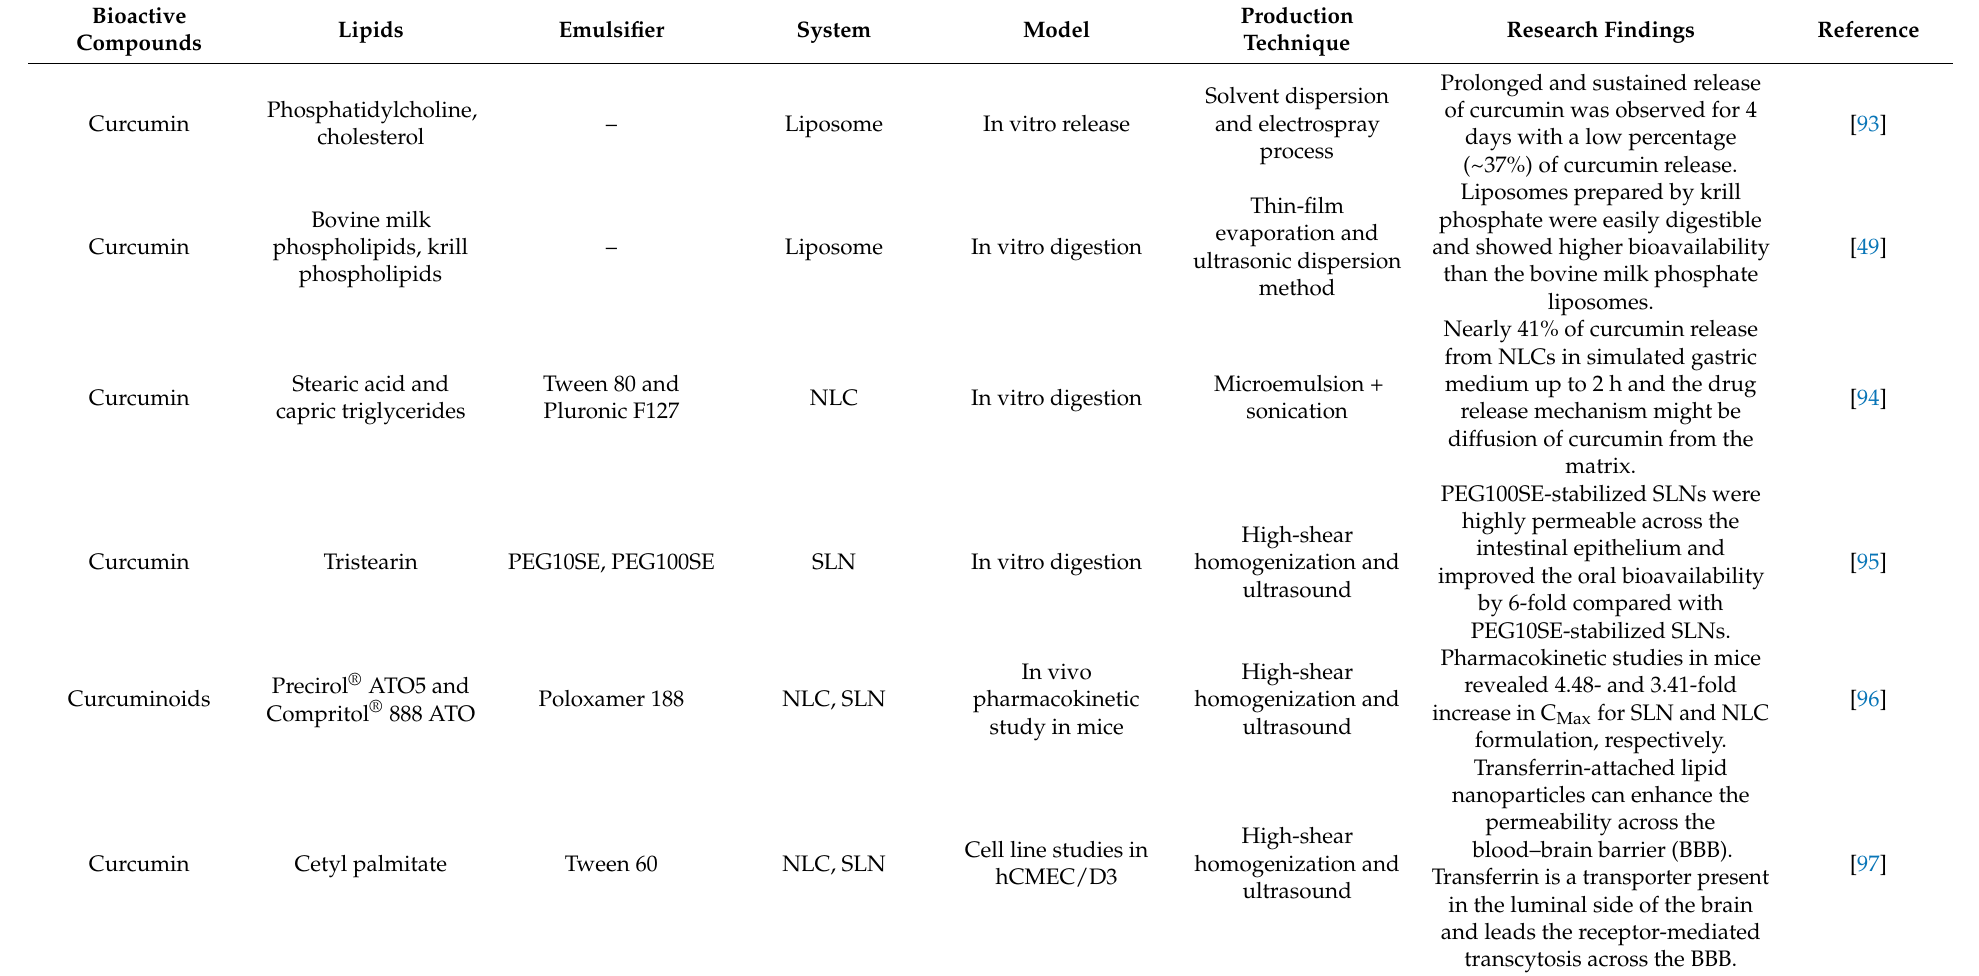
Table 3. Lipids and emulsifiers used for lipid nanoparticle